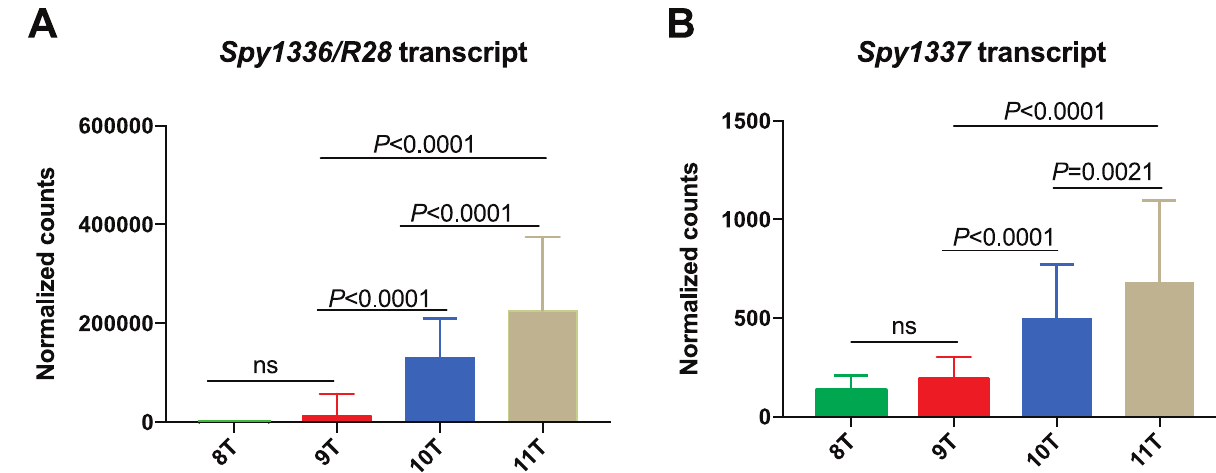
Fig 3. Transcript levels of Spy1336/R28 and Spy1337 in 421 M28 clinical isolates. RNAseq was performed on the isolates grown to early stationary phase, as described previously [38]. Transcript levels (normalized counts) of (A) Spy1336/R28 and (B) Spy1337 for strains with 8Ts ( n = 4), 9Ts ( n = 137), 10Ts ( n = 255) or 11Ts( n = 25) in the HT Spy1336-7 region. Mean expression levels are plotted and error bars represent standard deviation. P values were calculated using one-way ANOVA with Tukey’s multiple comparison test. ns, not significant.